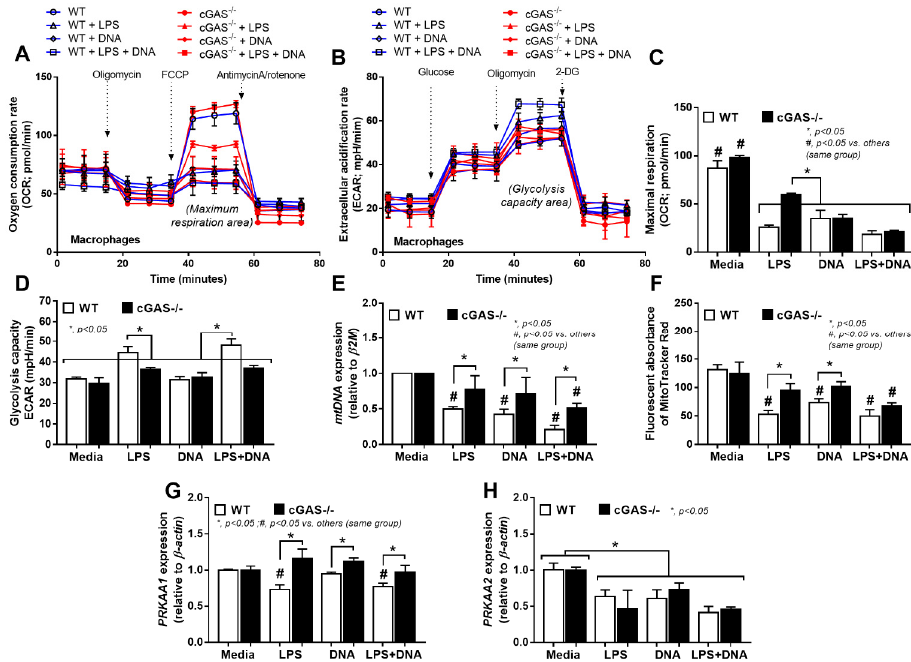
Figure 7. Characteristics of macrophages from wildtype (WT) and cyclic GMP–AMP synthase deficient (cGAS -/- ) mice after an activation by media control, lipopolysaccharide (LPS), bacterial DNA (DNA) and LPS with DNA (LPS + DNA), as indicated by oxygen consumption rate (OCR) (as determined by mitochondrial stress test) and extracellular acidification rate (ECAR) (determined by glycolysis stress test) ( A , B ), along with the graph presentation of maximal respiration and maximal glycolysis ( C , D ), mitochondrial abundance (using mitochondrial DNA (mtDNA) and MitoTracker fluorescent staining) ( E , F ) and expression of PRKAA1 and PRKAA2 (mitochondrial promotors) ( G , H ). Independent triplicated experiments were performed.